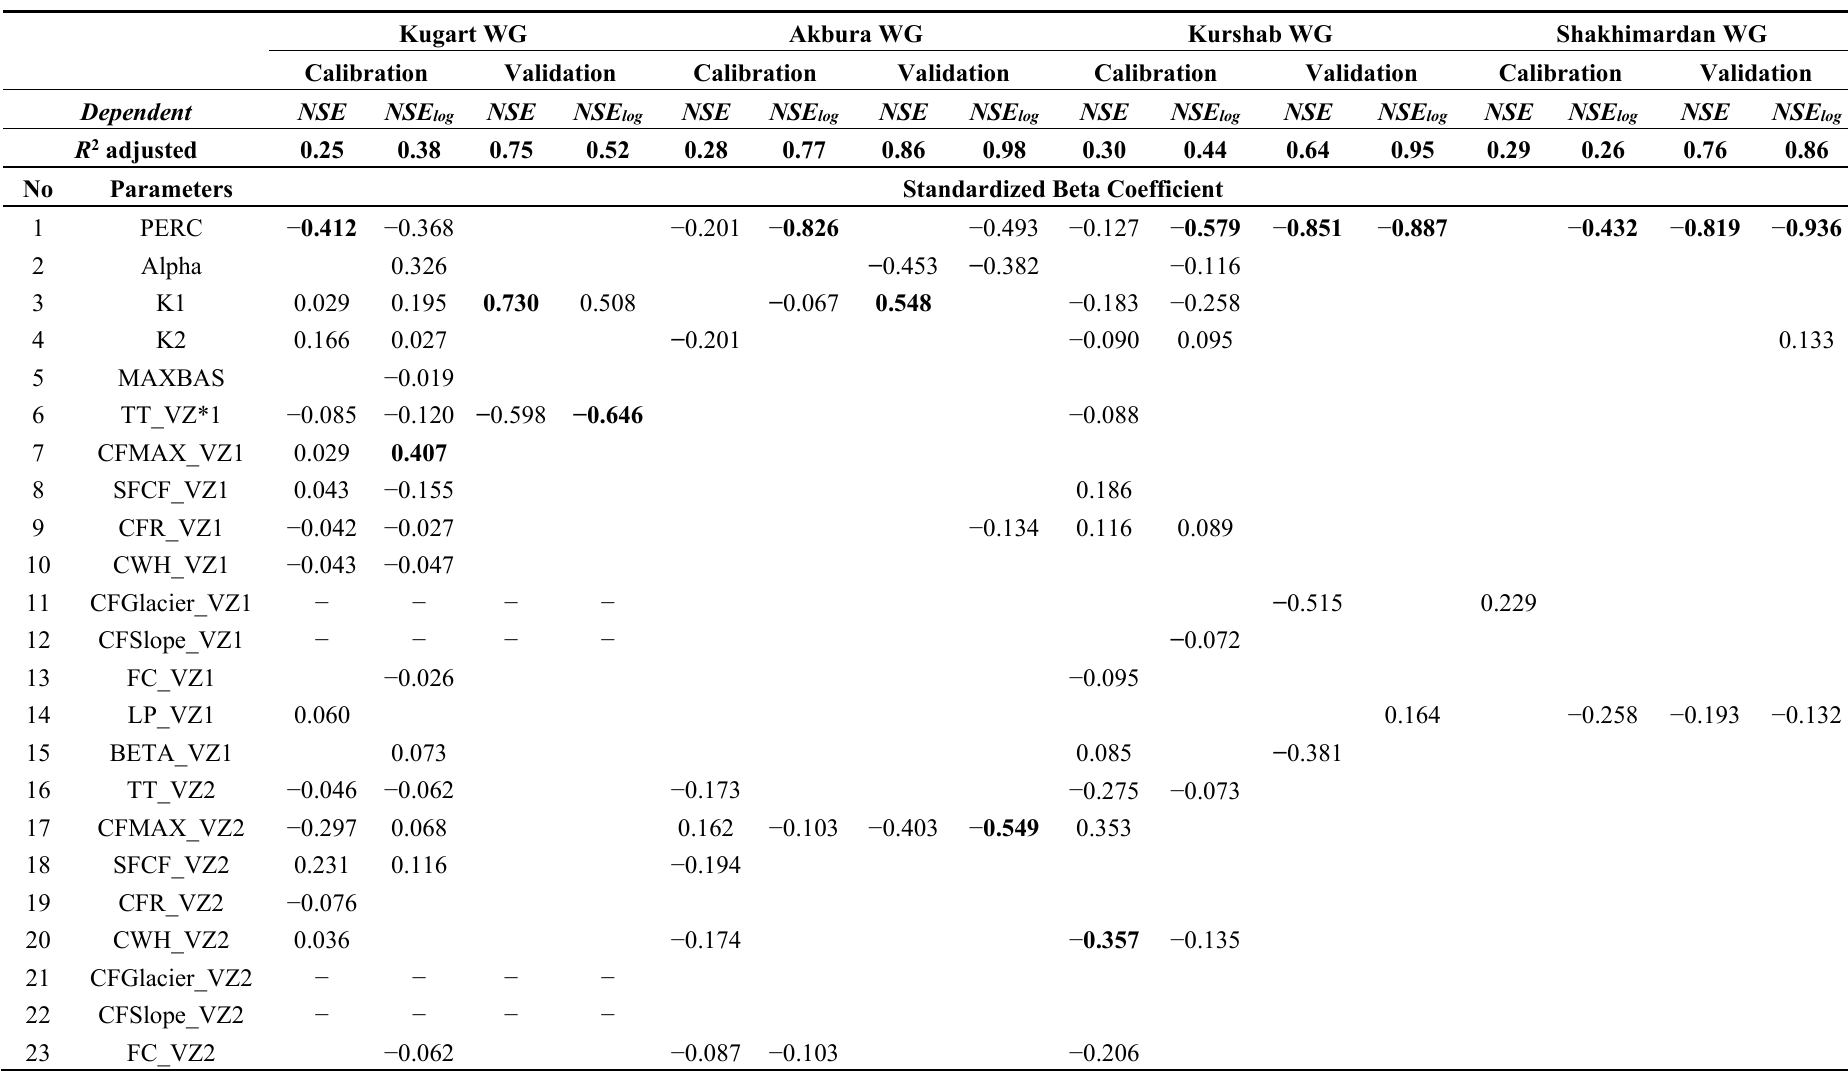
Table 7. Contribution of parameters in HBV-light model for the four studied catchments based on the adjusted coefficient of determination and standardized beta coefficient (VZ * = vegetation